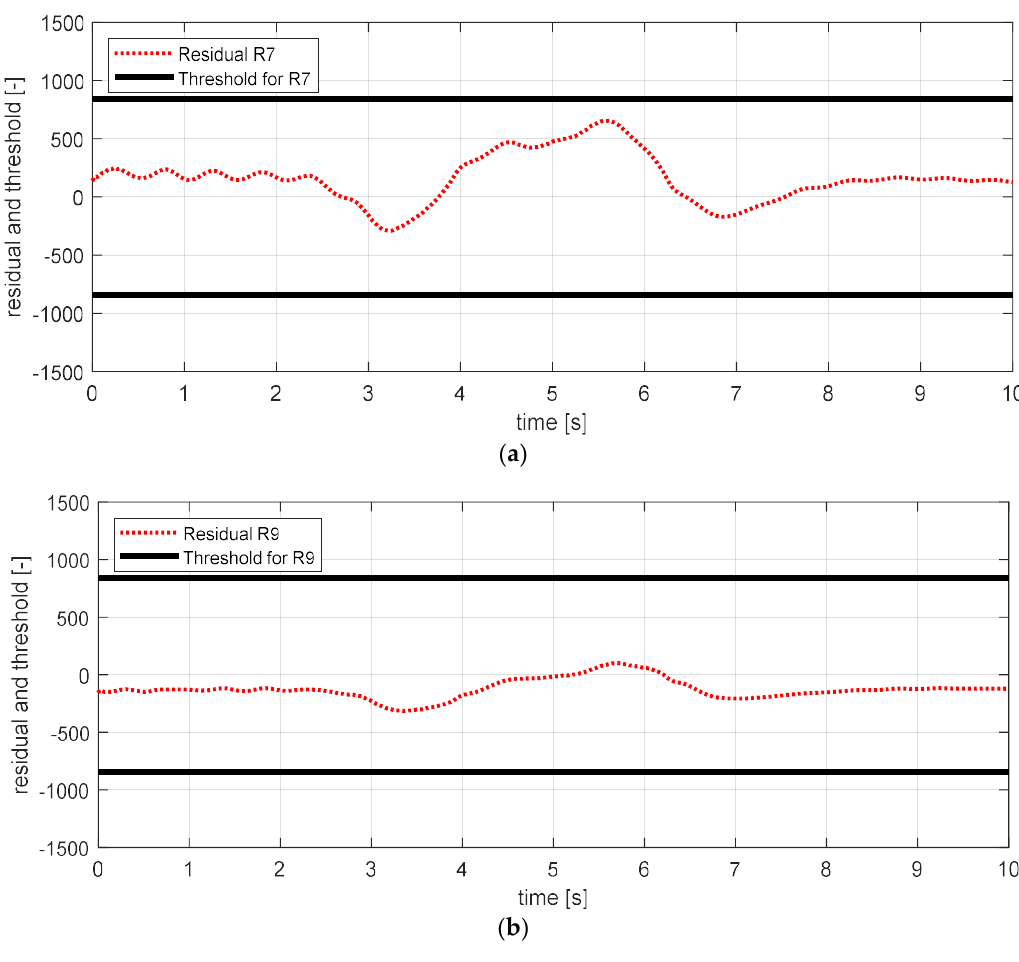
Figure 31. Simulation result for wheel vertical acceleration sensor—fl (normal). ( a ) Residual 7 and threshold; ( b ) residual 9 and threshold.